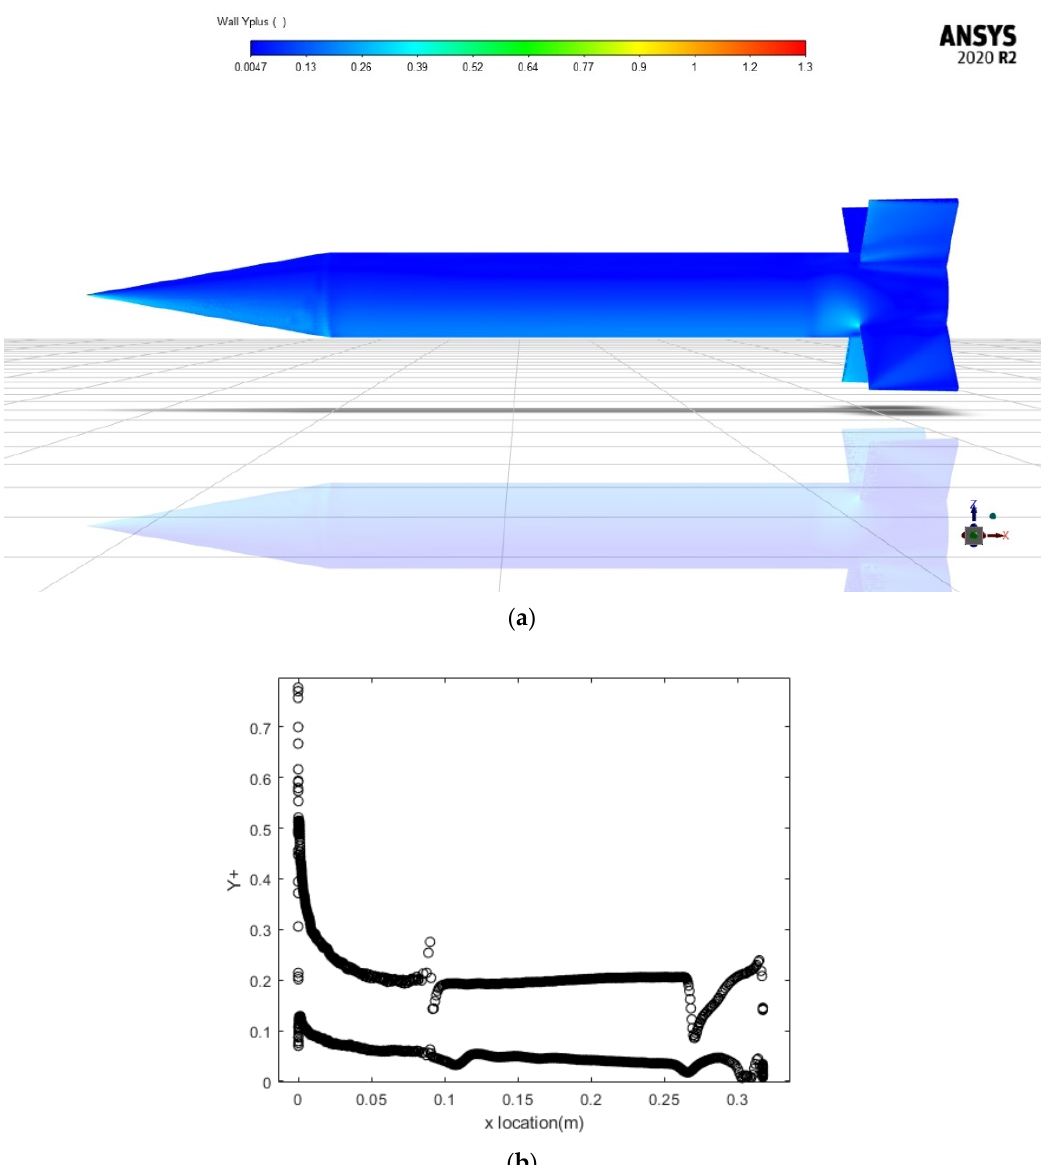
Figure 5. ( a ) Yplus distribution contour; ( b ) Yplus distribution plot along directional symmetry plane.